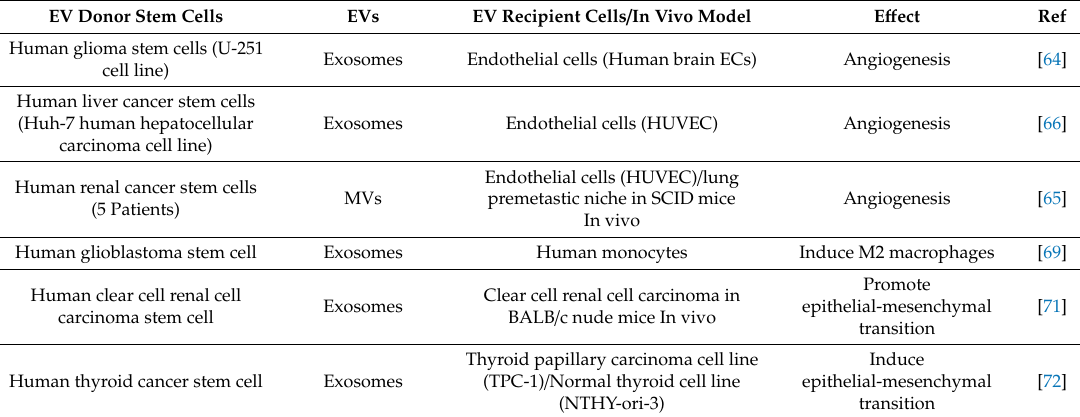
Table 1. E ff ect of cancer stem cell-derived extracellular vesicles (EVs) according to recipient cells or in vivo